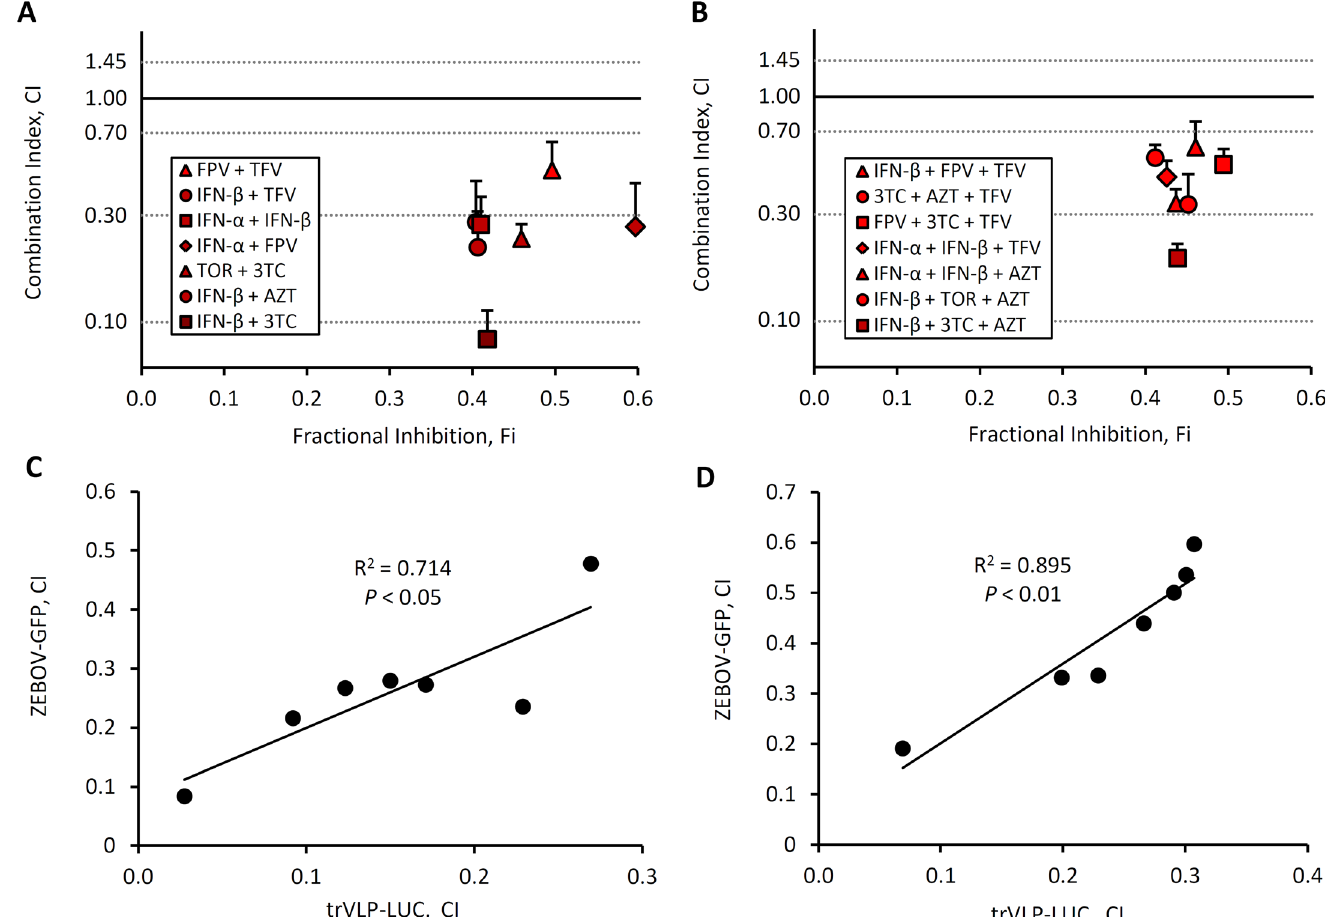
Fig 5. Synergistic 2 and 3 drug combinations against trVLP-LUC infection inhibit fully infectious ZEBOV-GFP. (A-B) 293 T cells were infected with ZEBOV-eGFP at an MOI of 0.1, then treated with 2 and 3 drug combinations as indicated, 24 hours post-infection, at their monotherapy IC 25 doses. GFP fluorescence was measured 3 days post-infection. Values are the means of 4 biological replicates, and error bars represent the standard error of the mean. Data are representative of 2 independent experiments. The combination index (CI) was plotted against the fractional inhibition (Fi) for each drug combination. (C-D) Plot of CIs for ZEBOV infections compared with CIs for trVLP